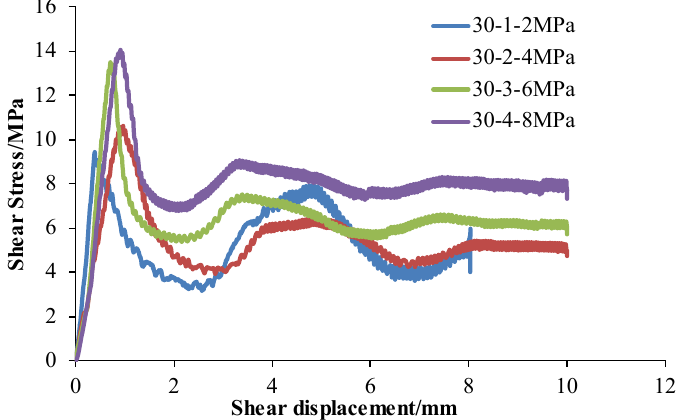
Figure 7. Shear stress–displacement curves under different normal stresses at a 0.6 mm/min shear rate with a 30° undulating angle.